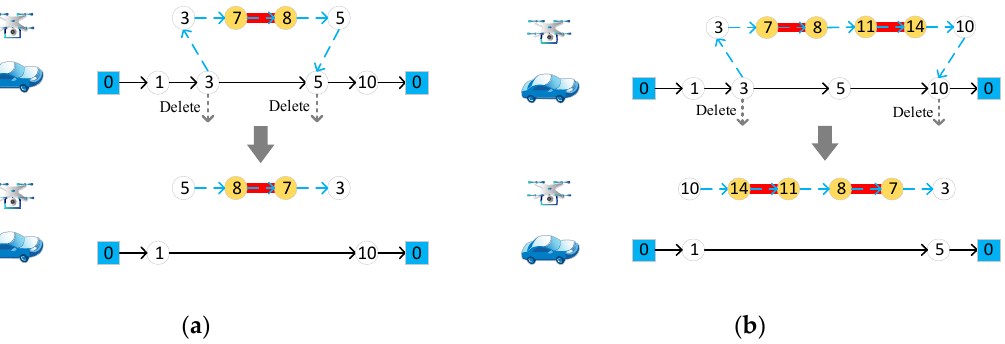
Figure 4. Change the access direction of target edges assigned to drones. ( a ) For one target edge in the drone route; ( b ) for multiple target edges. Different numbers in the figure represent different nodes of the road network.